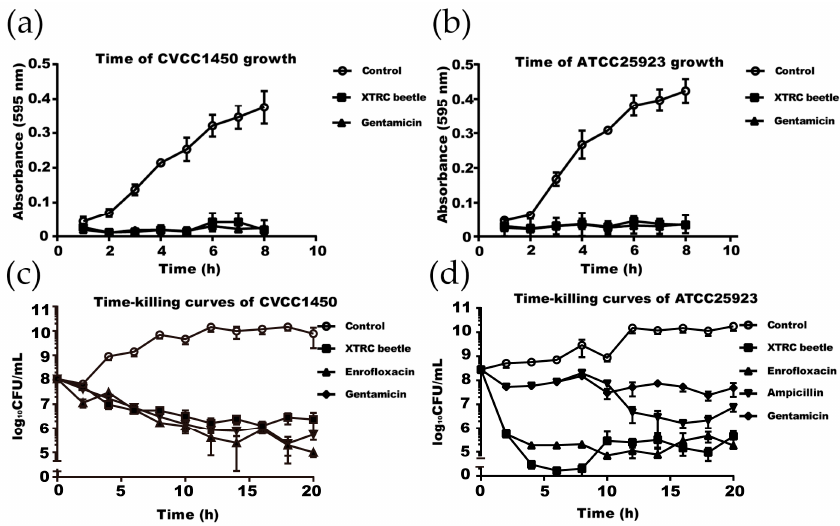
Figure 2. Timing course detection of Z. morio hemolymph in killing and inhibiting the growth of bacteria. ( a – d ) E. coli CVCC1450 ( a ) or S. aureus ATCC25923 ( b ) was incubated with 1 MIC of Z. morio hemolymph (0.5 mg / mL for E. coli and 1 mg / mL for S. aureus ). 1 MIC of gentamicin (0.5 µ g / mL) was used as a control drug in both assays. ( c , d ) E. coli CVCC1450 (10 8 CFU / mL) and ATCC25923 (10 8 CFU / mL) were incubated with 10 MIC of Z. morio hemolymph (5 mg / mL for E. coli CVCC1450 and 10 mg / mL for S. aureus ATCC25923). 10 MIC of gentamicin (5 µ g / mL) and enrofloxacin (1.25 µ g / mL) were used as control drugs in the E. coli group, and gentamicin (5 µ g / mL), enrofloxacin (2.5 µ g / mL), and ampicillin (20 µ g / mL) were used as control drugs in the S. aureus group. XTRC beetle stands for Z. morio hemolymph in this figure. These experiments were carried out in triplicate and the results are expressed as the mean ± SD.